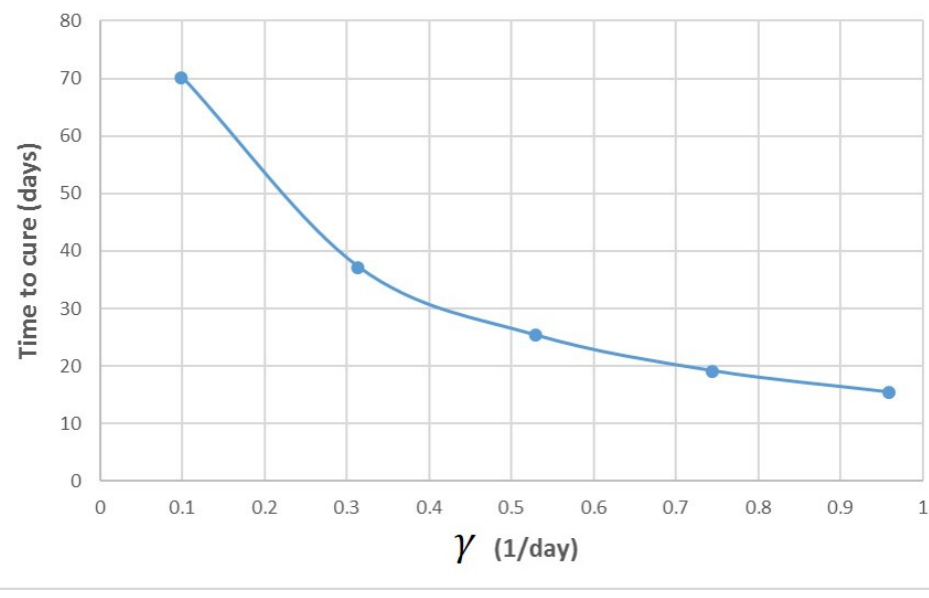
Figure A2. Influence of parameter γ in the multiscale model on